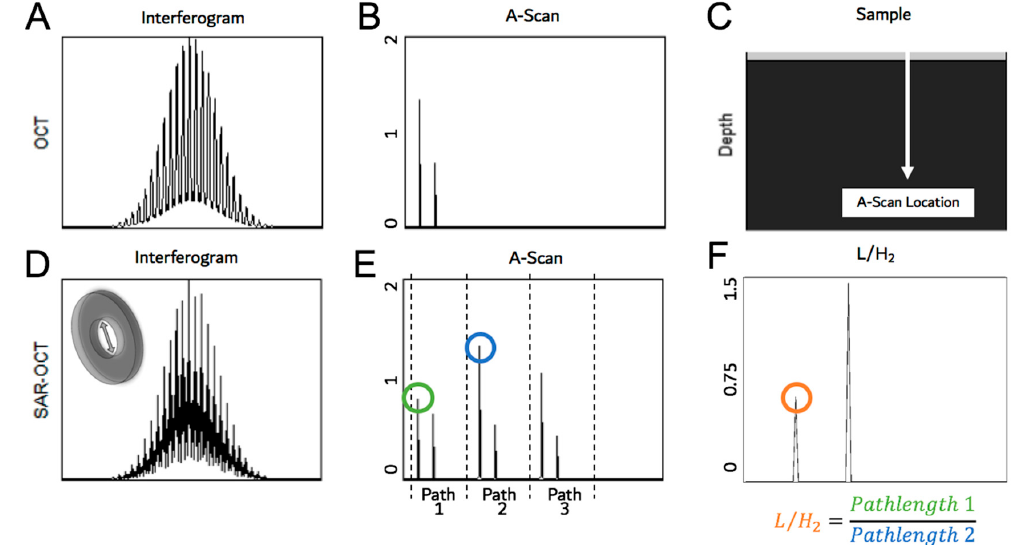
Figure 9. ( A ) A standard interferogram resulting from the A-scan in the sample ( C ). ( B ) The FFT of the interferogram; the peaks indicate the changes in refractive index that result in backscattering. ( D ) The way the interferogram changes with the introduction of a PME, and ( E ) the effect on the resultant A-scan. ( F ) The way the L/H 2 is calculated for the A-scan.